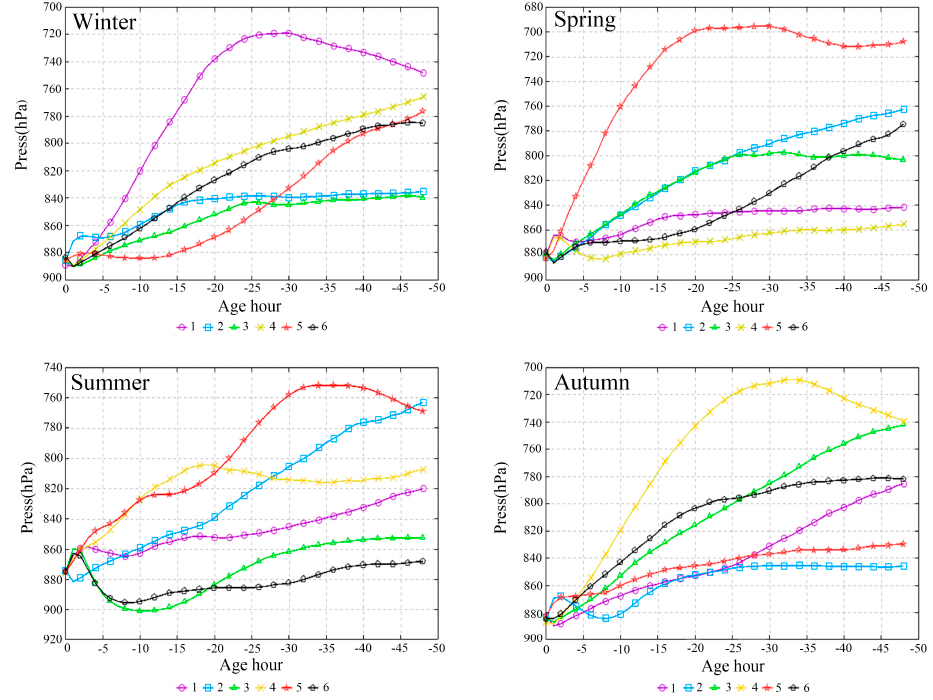
Figure 5. Air pressure profiles of the backward trajectories from January 2017 to December 2019.